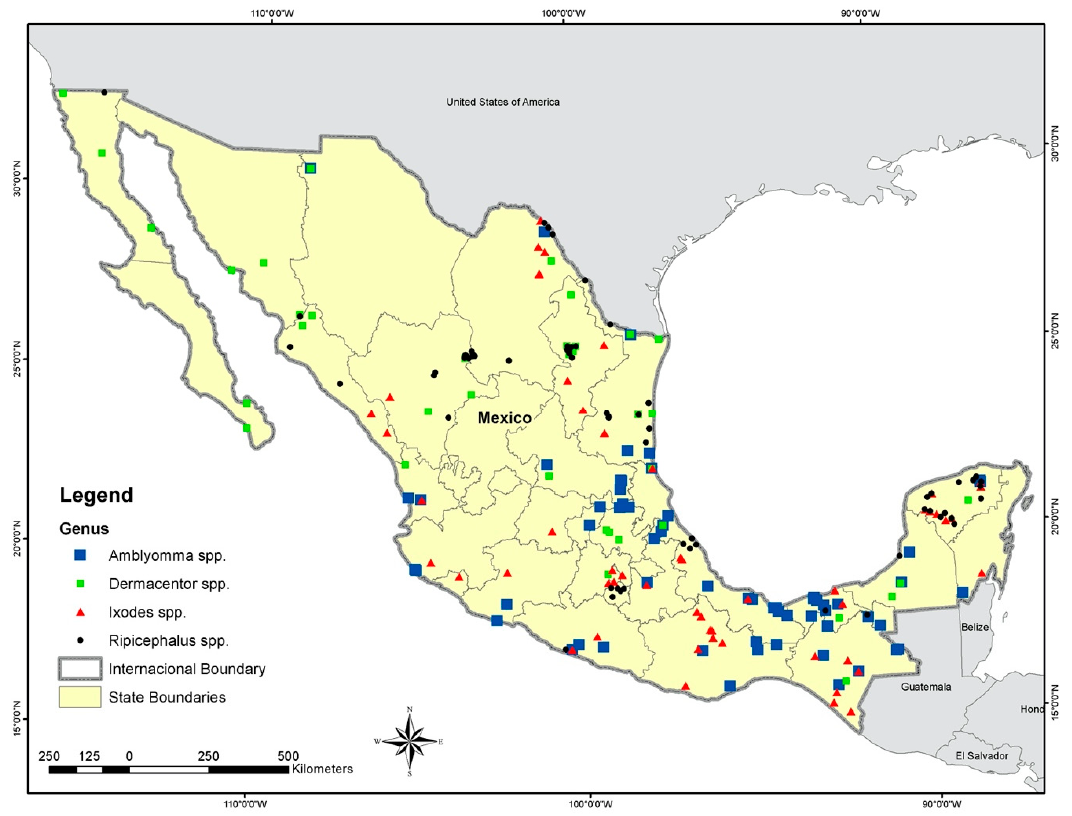
Figure 1. Records used to estimate the ecological niche models for the four tick genera: Black circles indicate the presence of Rhipicephalus spp., red triangles indicate the presence of Ixodes spp., and green and blue boxes show the presence of Dermacentor spp. and Amblyomma spp., respectively. Table 2. Area under the curve index (AUC) values for each of the models generated by tick genus. Algorithm Amblyomma spp. Dermacentor spp. Ixodes spp.